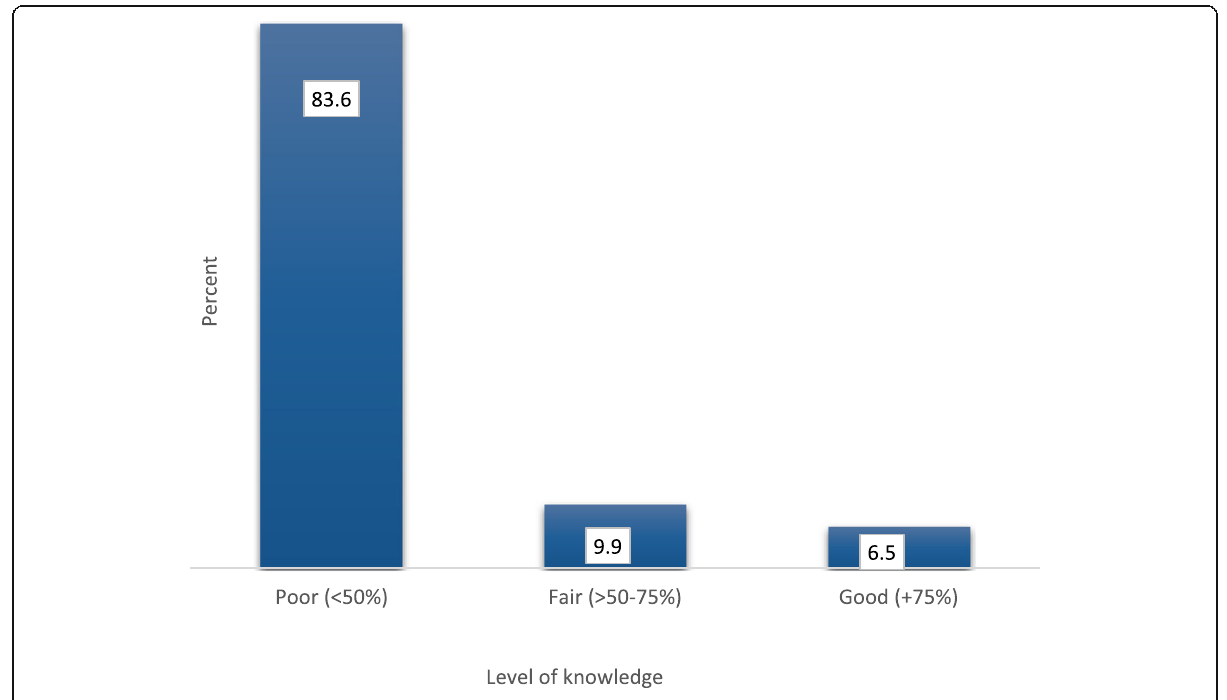
Fig. 2 Level of knowledge of reproductive-age women in Alexandria regarding TTV and MNT, 2018